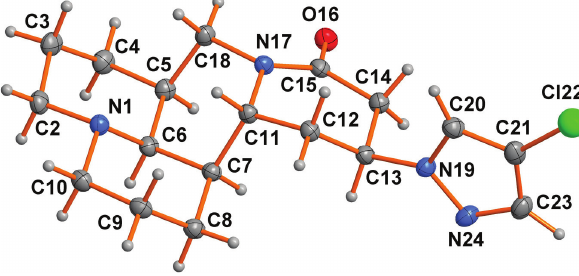
Table 1: Data collection and handling.